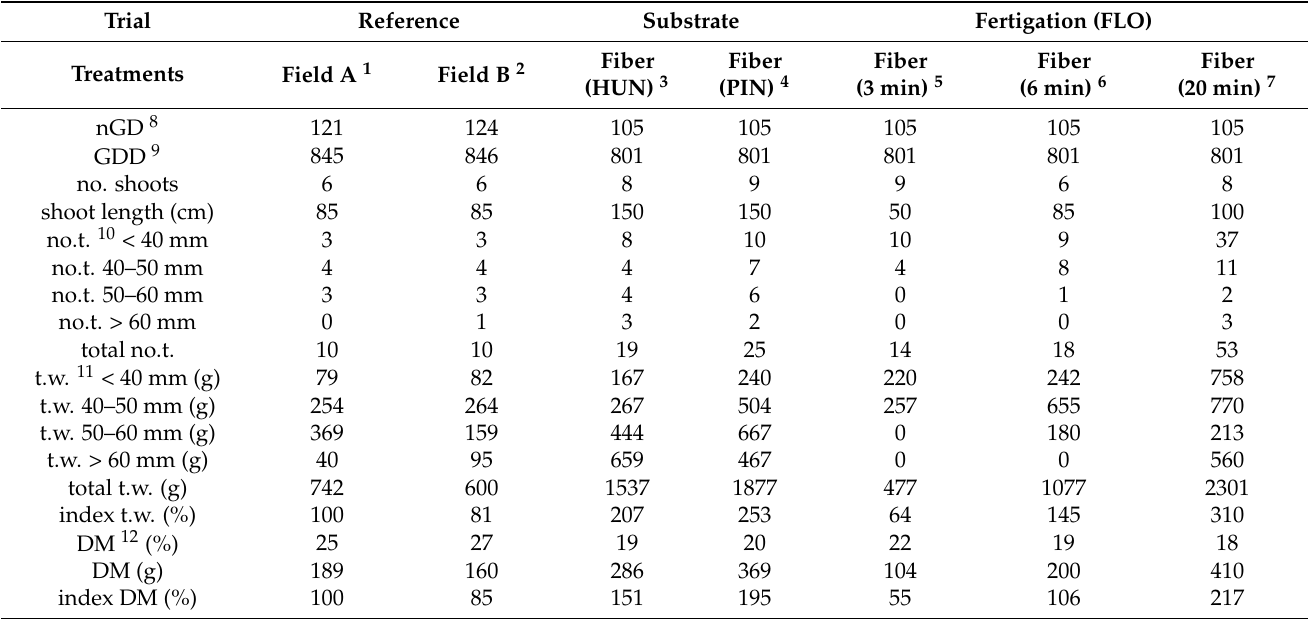
Table 1. Comparison between the parameters of potatoes grown in field and hydroponically in wood fiber.